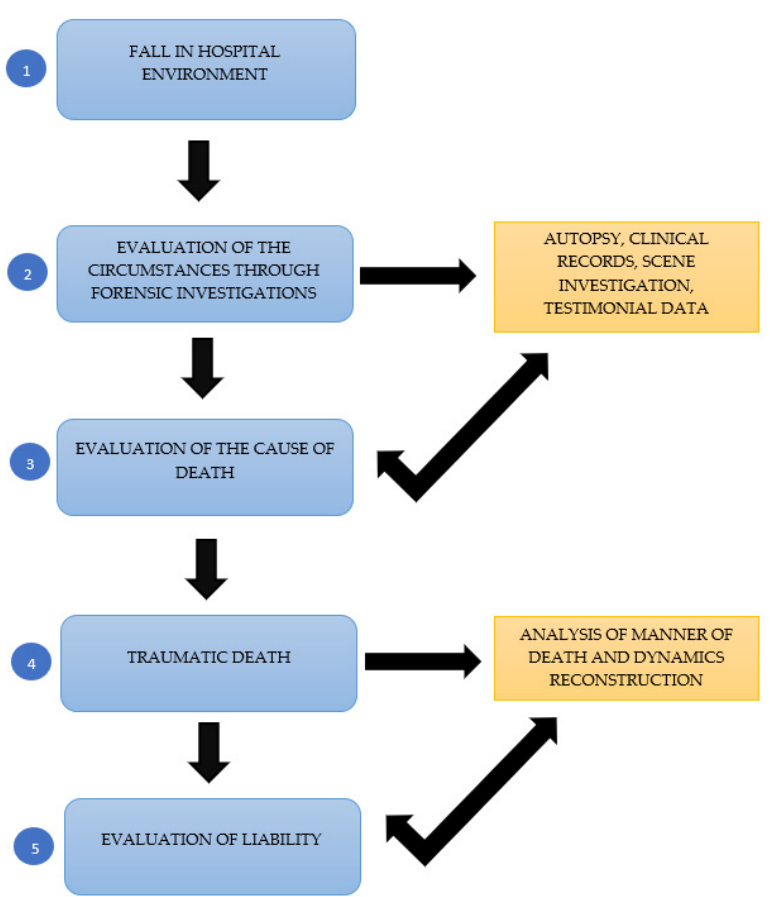
Figure 6. Post ‐ mortem diagnostic protocol in case of trauma. Figure 6. Post-mortem diagnostic protocol in case of